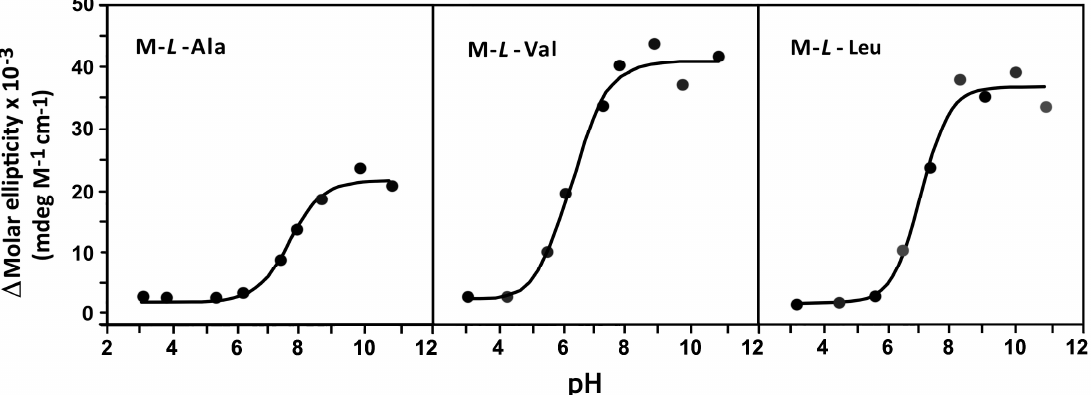
Figure 4. pH Dependence of M- L -Ala, M- L -Val and M- L -Leu differential molar ellipticity at 228, 234 and 231 nm, respectively. Operational conditions: 1.83 ± 0.17 mM repeating units in 0.1 M NaCl solution. Based on data points reported in Figure S5.